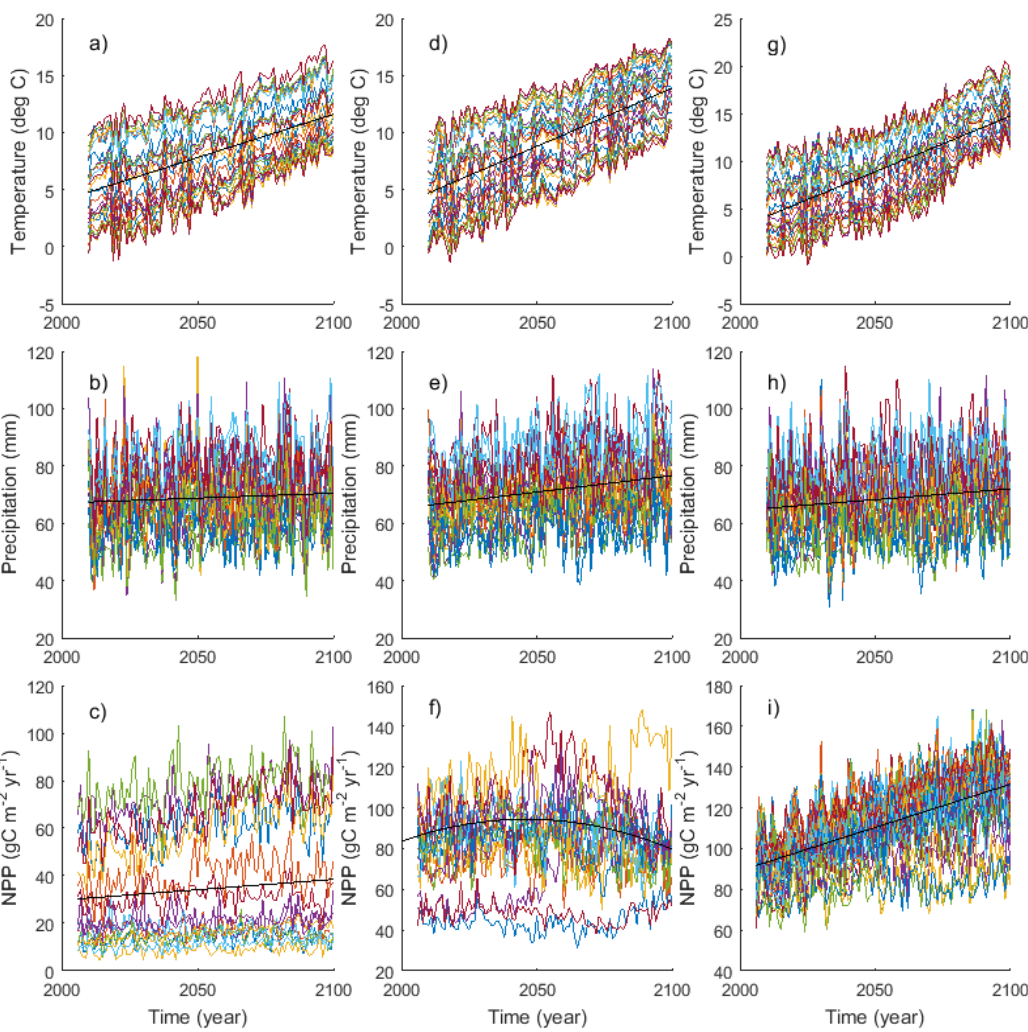
Figure 2. Time series of simulated temperature, precipitation and Net Primary Production (NPP) from three global climate models; ( a – c ) CanESM2 (Canadian); ( d – f ) MIROC (Japanese); and ( g – i ) MPI (European) for IPCC future climate scenario RCP 8.5 for each grid (~10 km × 10 km) over the study area. Each line represents a grid-specific value from 2006 to 2100. Fitted average lines are also shown. There was a clear spatial gradient in NPP across the study area, with higher average NPP